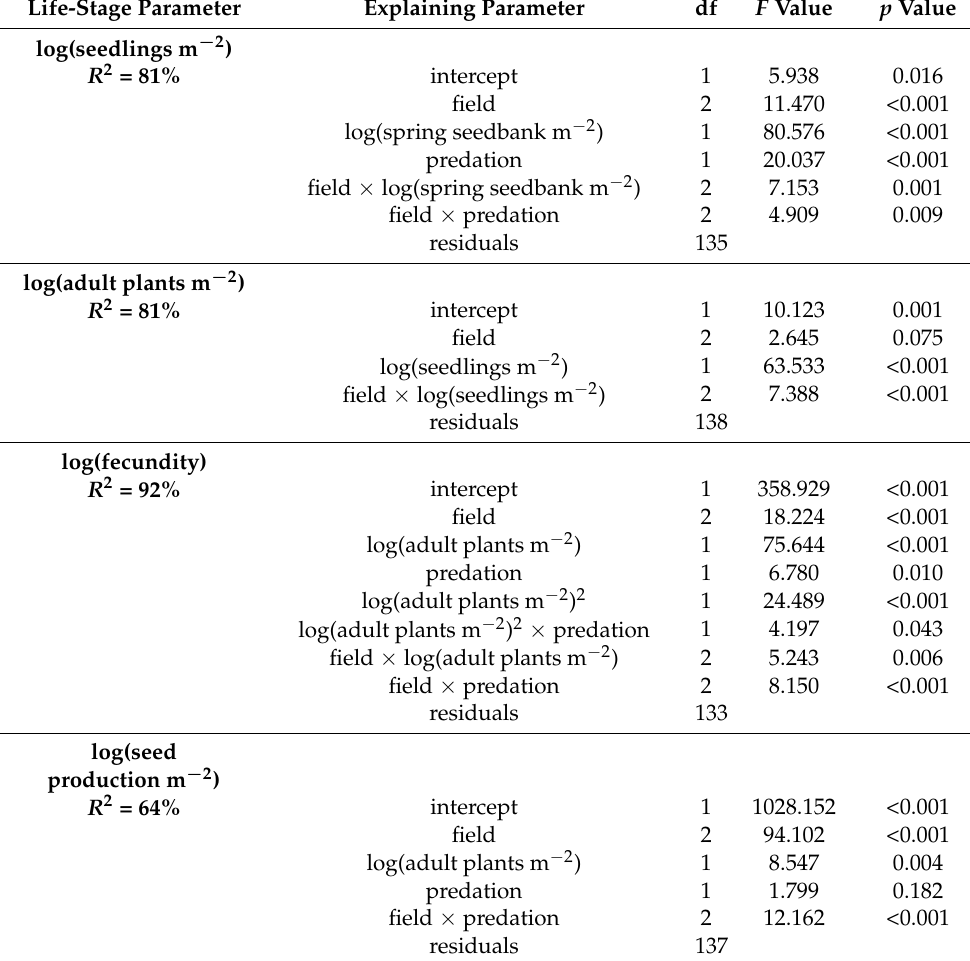
Table A1. Analysis of variance (type 3) of the best-selected linear regression model to describe the log explaining variables (field, log previous life-stage, weed seed predation, and first-order